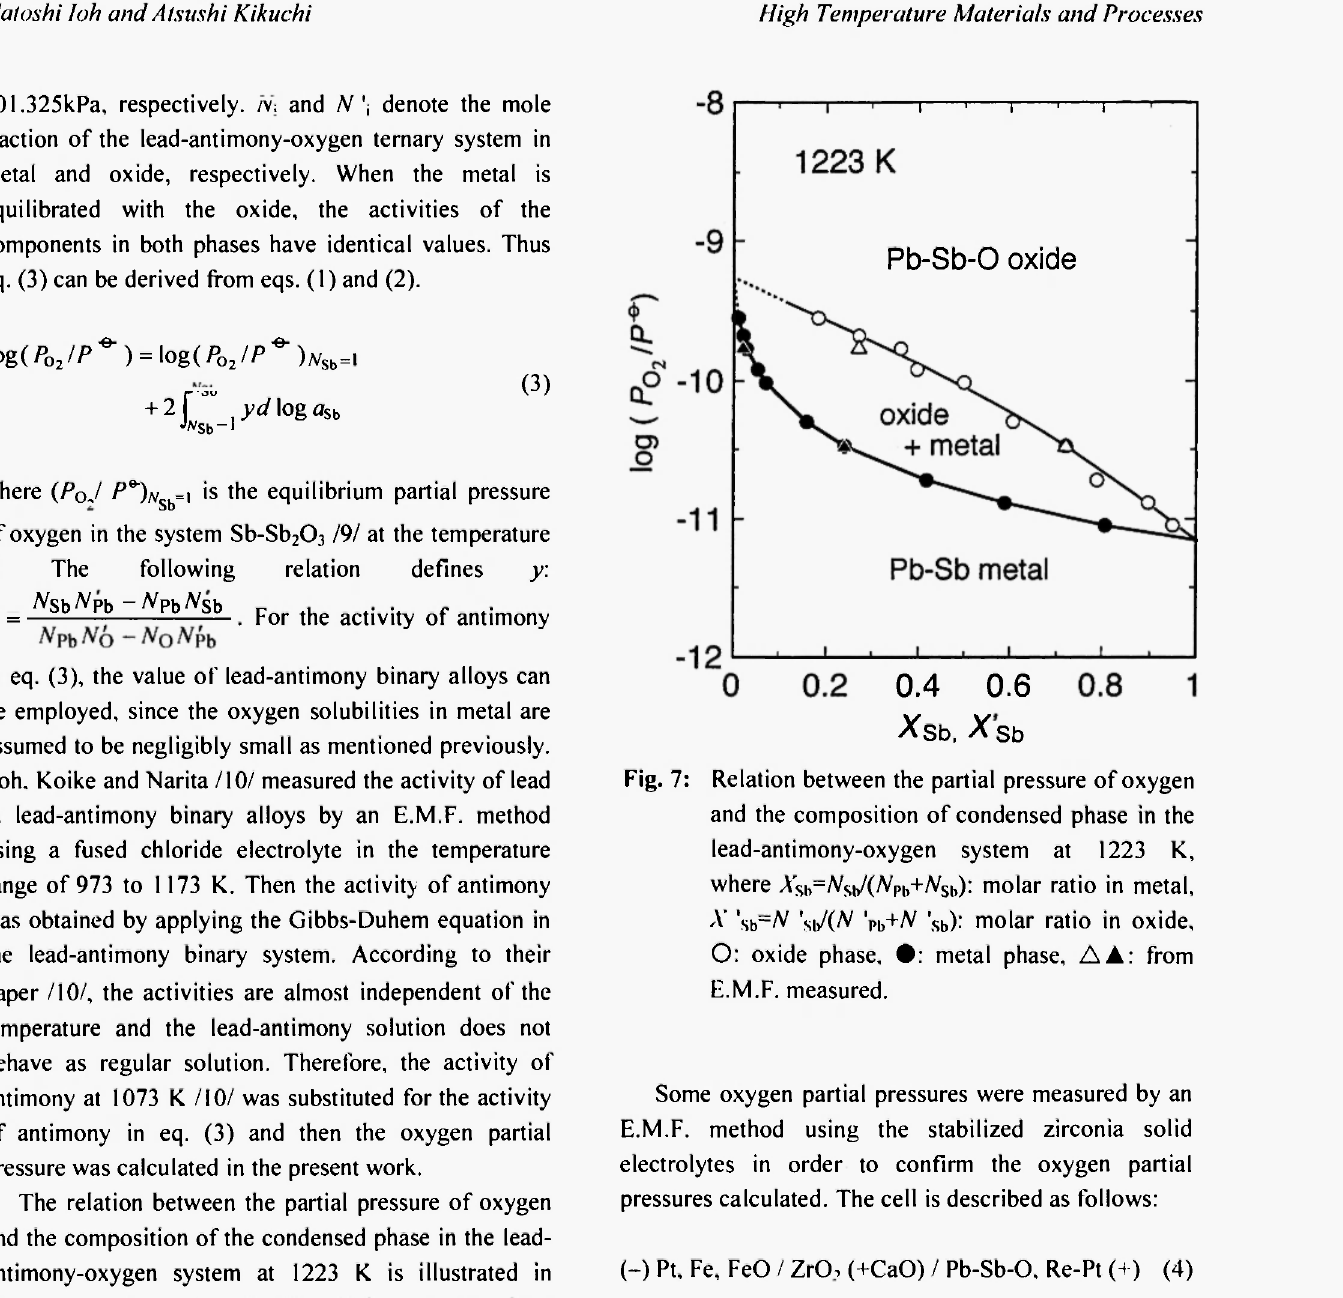
Figure 7, where X^N sb /(N Ph +N Sh ) and A" sb =/V' s „/ (WVb+A'sh) denote the molar ratio in metal and oxide phases, respectively. In the figure the left and right hand sides correspond to Pb-PbO and Sb-SbO, 5 (Sb 2 O.0 sides, respectively. The symbols of the open and closed circles correspond to the oxide and metal phases, respectively. An oxide phase is stable above the line connecting the open circles, while a metal phase is stable below the line connecting the closed circles. Between the two lines the two liquid phases of metal and oxide coexist.